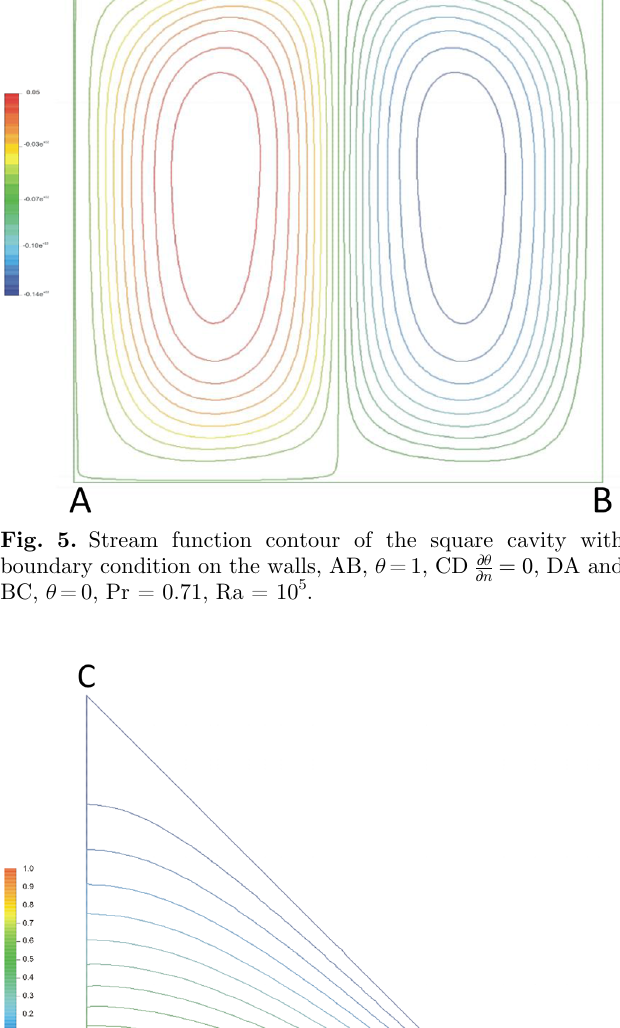
Fig. 6. Temperature contour of the triangular cavity with boundary condition on the walls, AB, u =1, CA, ∂ u ∂ Pr = 0.71, Ra = 710. ¼ 0 , DA and BC, u =0, n